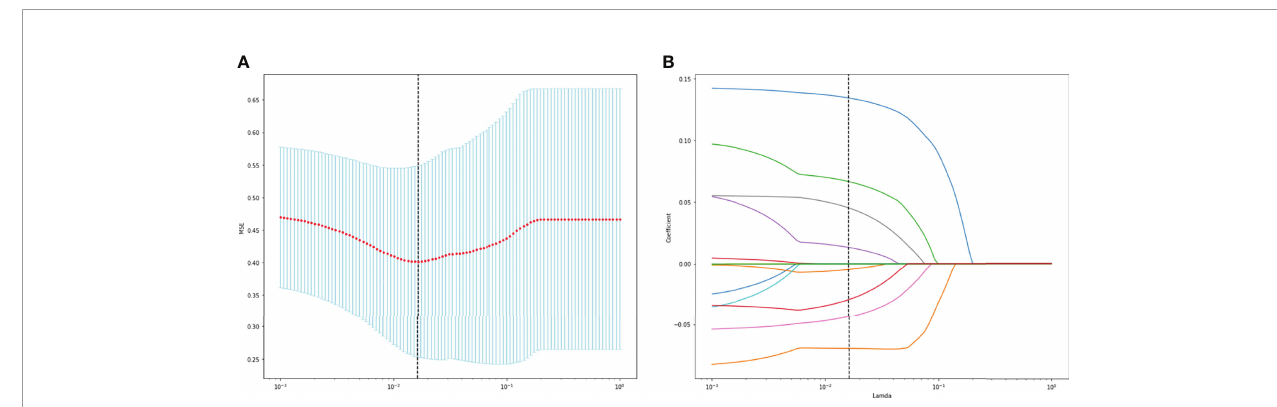
FIGURE 2 | (A) The change of MSE corresponding to the LASSO method. (B) Lamda value screening of LASSO